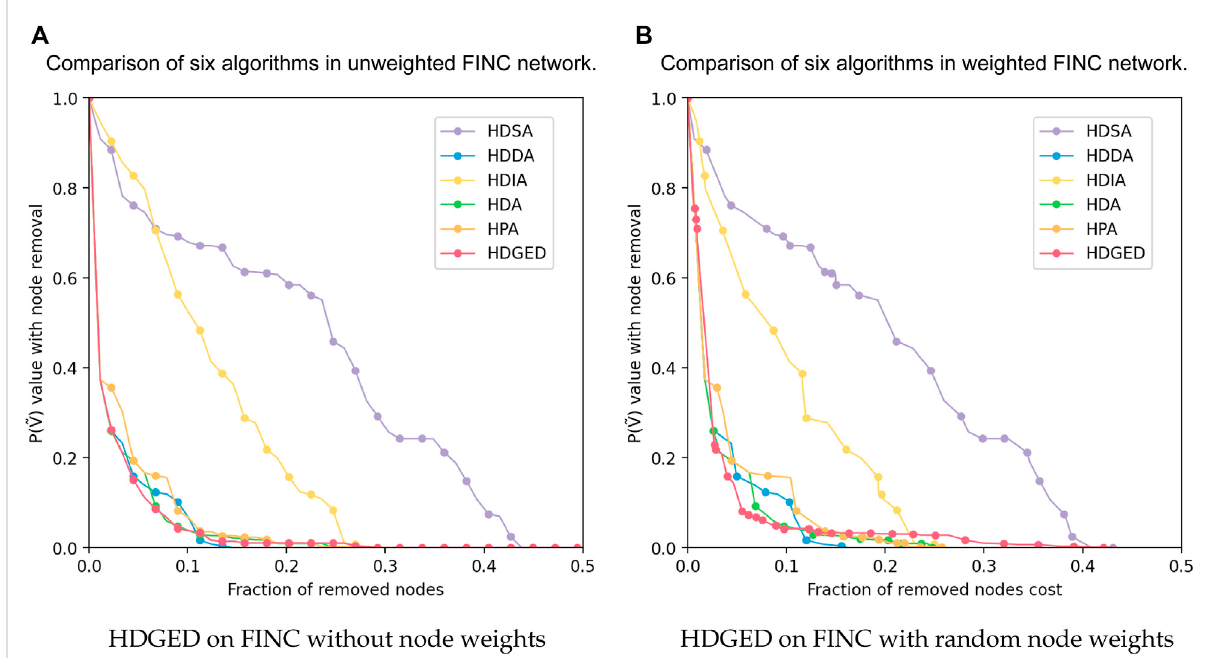
FIGURE 14 The performance of HDGED on the FINC military network without considering the attack cost and considering the attack cost. It can be seen that with the removal of nodes, the network performance gradually decreases. (A, B) Shows speci fi cally the degradation of the operational performance of the FINC network when facing HDGED and other baseline